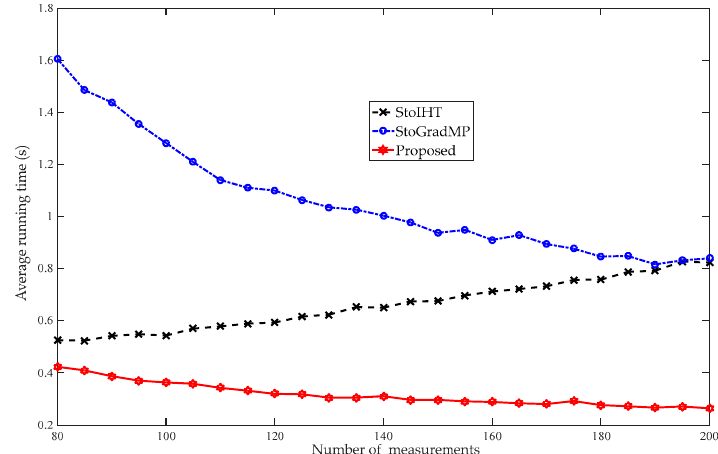
Figure 14. Average running times of the di ff erent algorithms ( d = 100, R = 1, κ = 0.2, m = 80 : 5 : 200, randomly low-rank matrix).